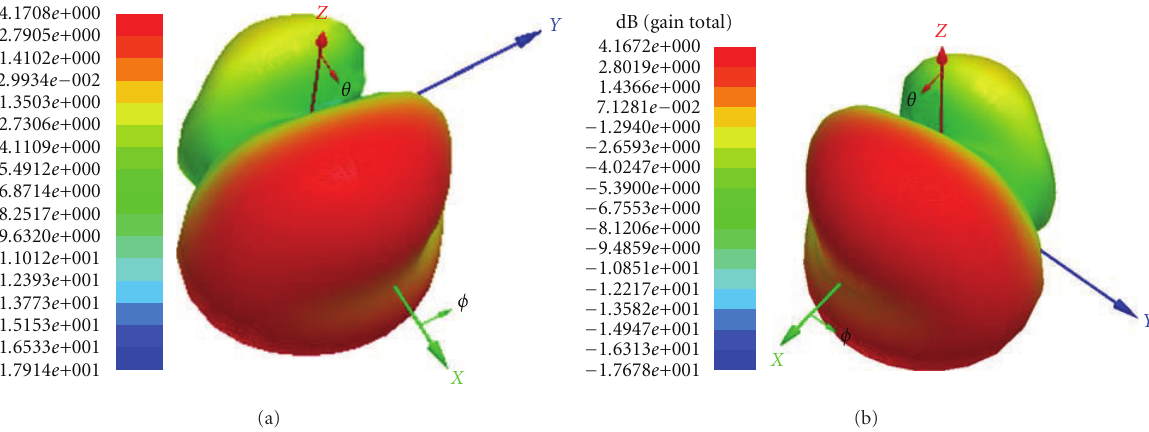
Figure 7: Simulated 3D radiation pattern at 2.5 GHz. (a) Antenna 1 excited. (b) Antenna 2